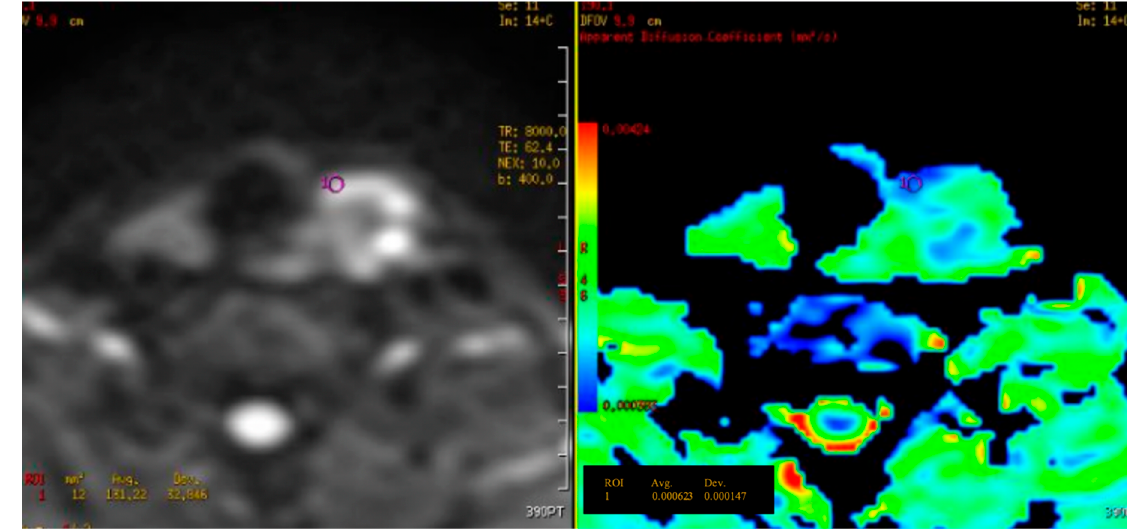
Figure 3. Mean ADC value of a malignant thyroid nodule with b = 800 is 0.62 × 10 − 3 mm 2 /s. Histopathology result: Papillary carcinoma.